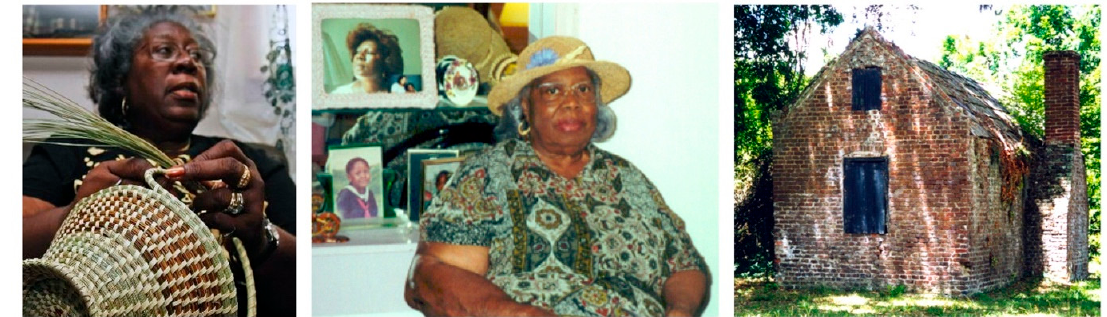
Figure 11. Boone Hill legacy collage. ( Left ): Jeanette Lee, whose family descended from the Boone Hall plantation, sewing a sweetgrass basket. Photograph courtesy of Kyle Stock. ( Middle ): Jeanette’s mother, Ms. Mattie Gaillard, at her home in Mt. Pleasant, South Carolina. ( Right ): The former slave cabin where Ms. Mattie grew up in on Boone Hill plantation in Charleston County, South Carolina. Photographs by Antoinette Jackson.